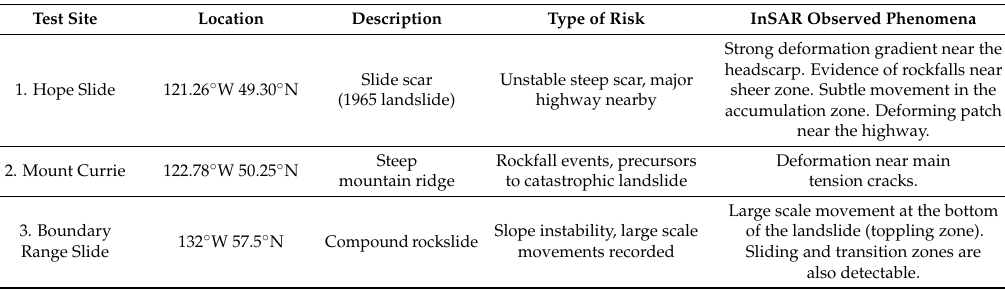
Figure 2. Network of the generated interferograms based on temporal (Btemp) and perpendicular (Bperp) baselines for ( a ) Hope Slide; ( b ) Mount Currie; ( c ) Boundary Range Slide (ascending); ( d ) Boundary Range Slide (descending). For each test site, the deformation maps of Section 4 are generated using the interferograms highlighted in blue. Table 1. Case studies and their characteristics.